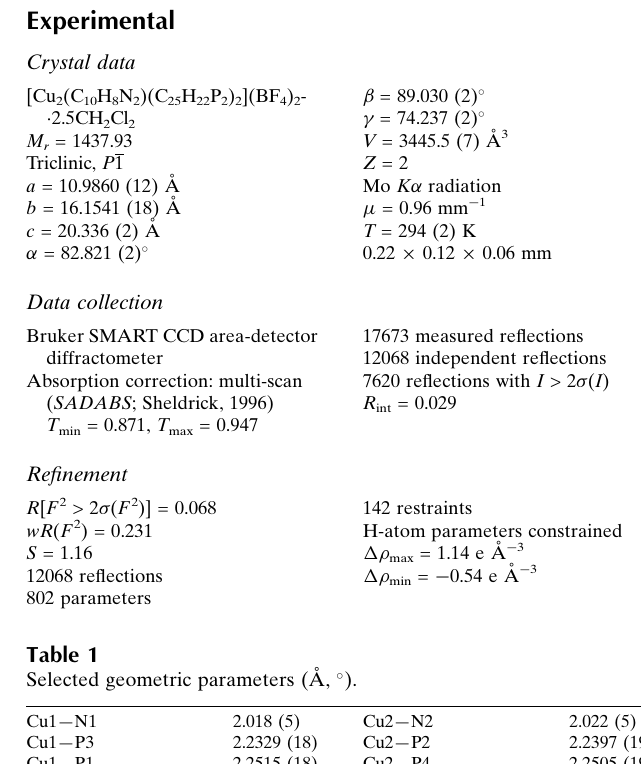
Cl } , contains chains of Cu I centres bridged alter- 2.5CH n 2 2